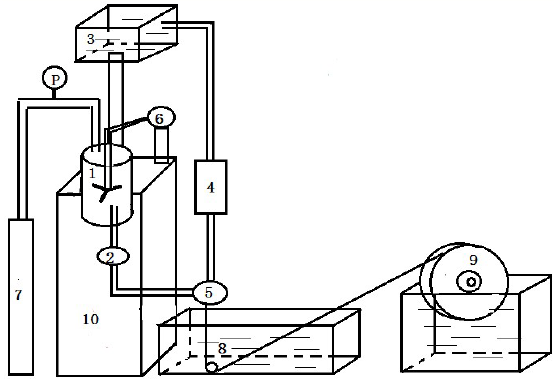
Figure 1. The schematic of polyvinylidene fluoride (PVDF) hollow fiber spinning